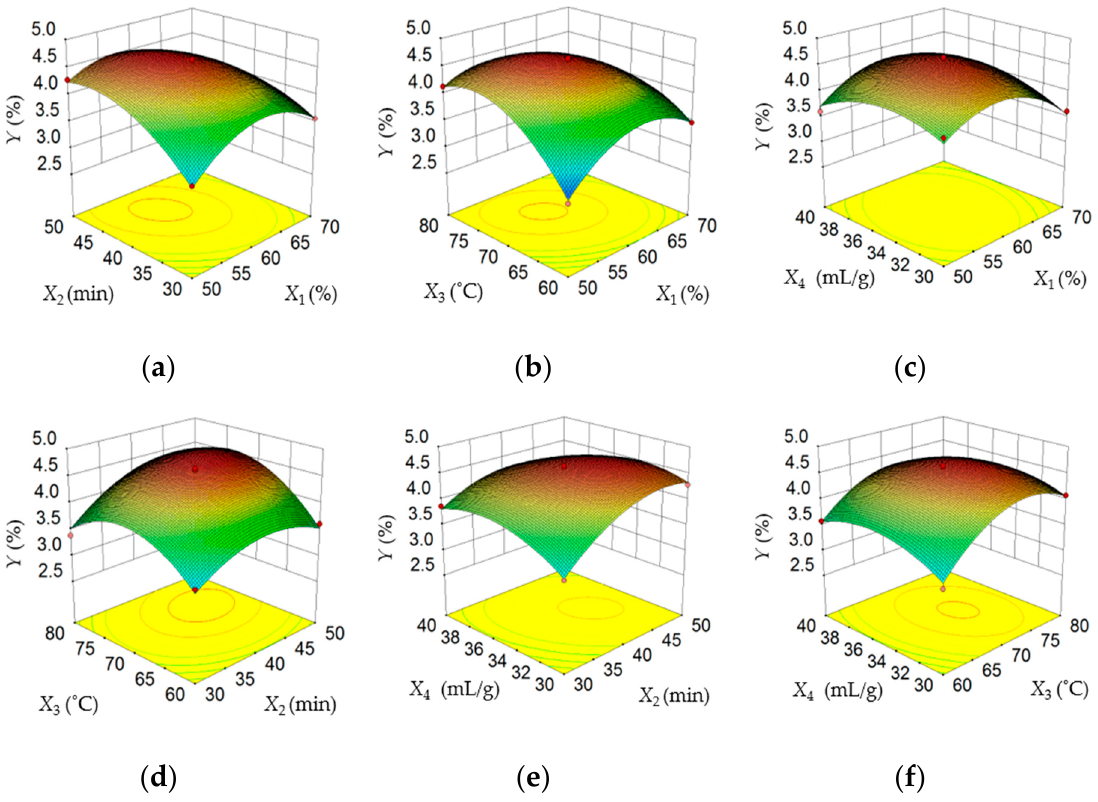
Figure 2. Response surface plots showing interaction between different variables ( X 1 : Ethanol concentration; X 2 : Extraction time; X 3 : Extraction temperature; and X 4 : Liquid / solid ratio) on the TFY.